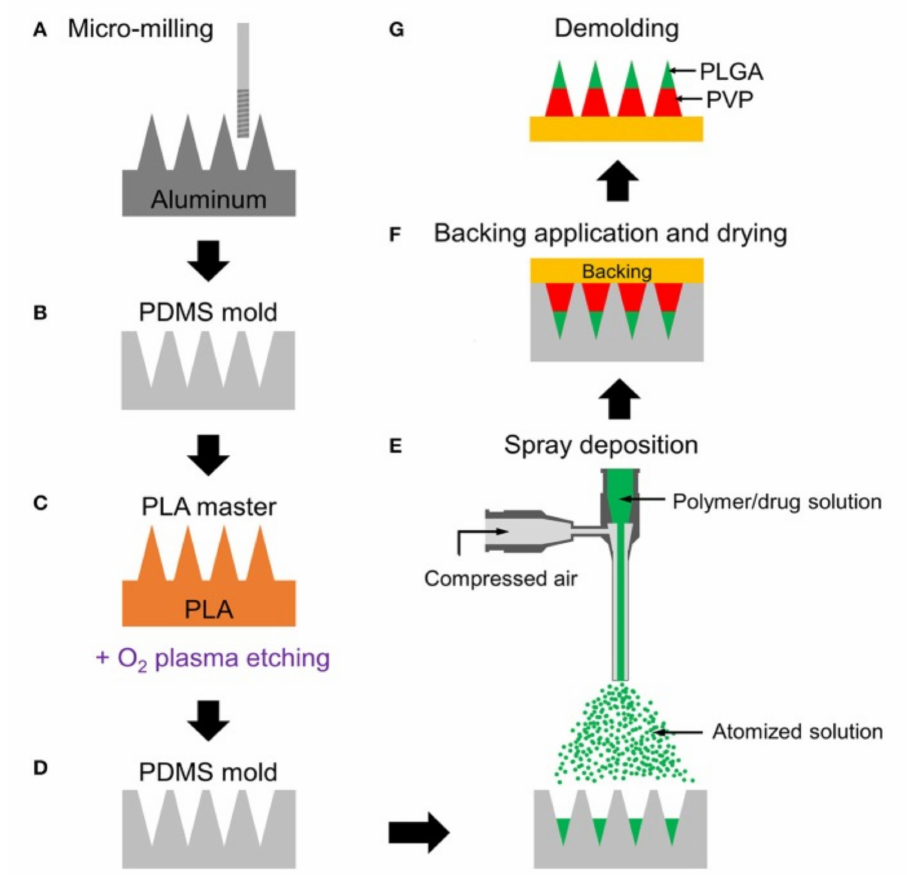
Figure 13. Schematic fabrication process of multilayer MNs: ( A ) Aluminum master fabrication using micro-milling. ( B ) Replication of PDMS mold from the master. ( C ) Fabrication of PLA master by micromolding and tip-sharpening using oxygen plasma. ( D ) Replication of PDMS mold from the PLA master. ( E ) Spray deposition of drug-containing polymer solution to fill the mold cavity. Multilayer MN is formed by sequential deposition of polymer solutions. ( F ) Application of backing material (yellow) on the mold and drying at room temperature for polymer solidification. ( G ) Demolding solidified multilayer MN array from the mold. Green and red represent PLGA and PVP layers, respectively [147]. Reproduced with permission from Min Jung Kim et al., Fabrication of Circular Obelisk-Type Multilayer MNs Using Micro-Milling and Spray Deposition; published by Frontiers in Bioengineering and Biotechnology,